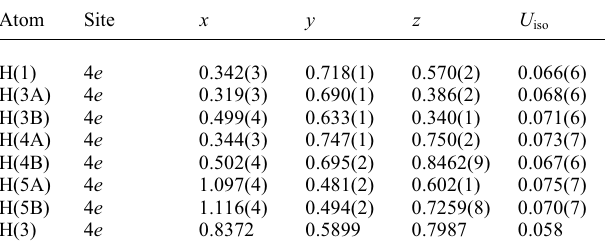
Table 2. Atomic coordinates and displacement parameters (in Å 2 )